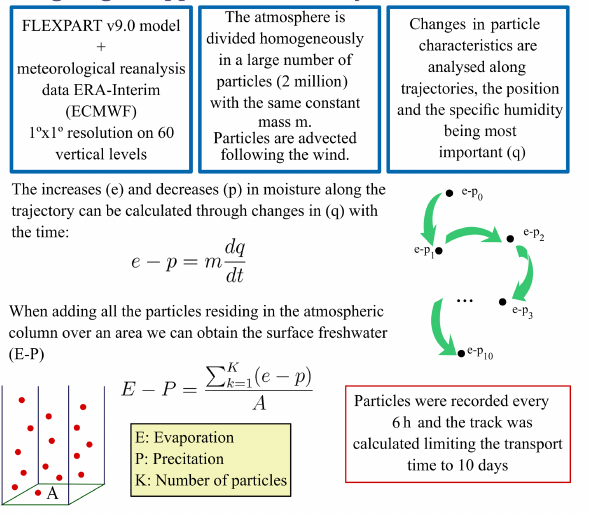
Figure 3. A scheme of the Lagrangian approach used to estimate moisture